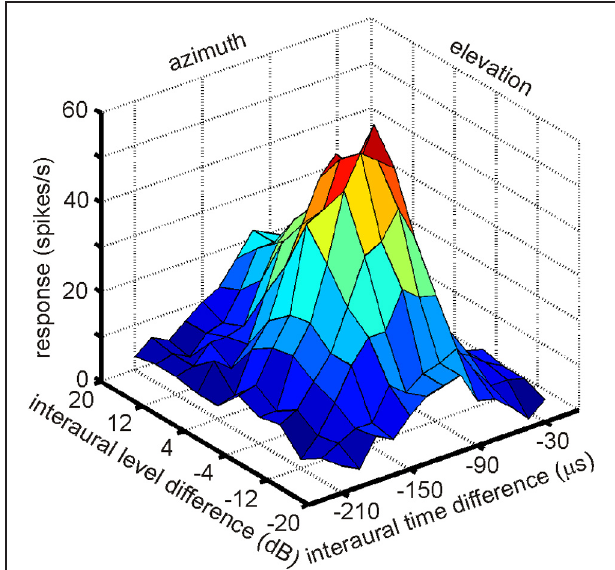
FIGURE 7 | A multiplicative receptive field of an ICX neuron. The response of this cell depends on ITD, which correlates with azimuth and on ILD, which correlates with elevation. Note that the responses in the two orthogonal directions, azimuth and elevation, are independent, because the shape of the curve of one parameter remains constant as the other parameter is changed. Only the height of the peak